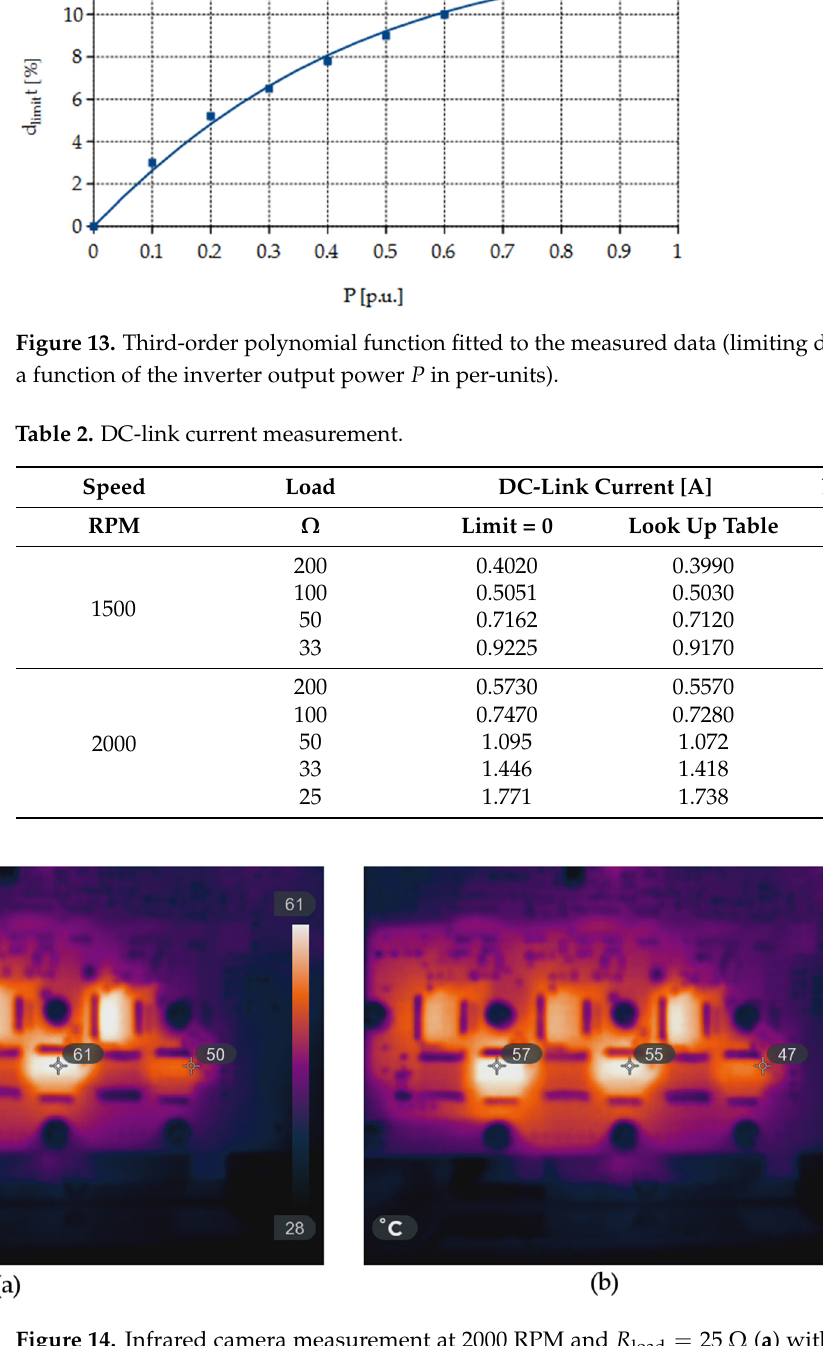
Figure 15. Detail of the inverter board. 4. Discussion In this paper, GaN-based converter losses caused by the current-collapse phenome- non and their mitigation, respectively, were investigated. It was explained that the addi- tional losses are caused by increased dynamic on-state resistance, which depends on the pulse length in the utilized modulation strategy. Following this, the SVPWM of a three- phase VSI driving a PMSM in a basic FOC loop was adjusted by limiting the minimum pulse for the GaN gate drivers. It was found that the modulated voltage distorted by the pulse length limiting lowers the current-collapse losses and, at the same time, causes ad- ditional machine losses because current distortion is introduced. Since both the converter and motor losses depend on the duty cycle limit value, optimal minimum pulse length corresponding to minimum consumed power for a given steady-state operating point can be determined. Moreover, it was experimentally observed that the optimum limiting duty cycle value depends on the converter input power. Therefore, a compensation function was implemented within the motor control algorithm to set the duty cycle limit with re- spect to the actual VSI input power calculated from the motor currents and voltages.